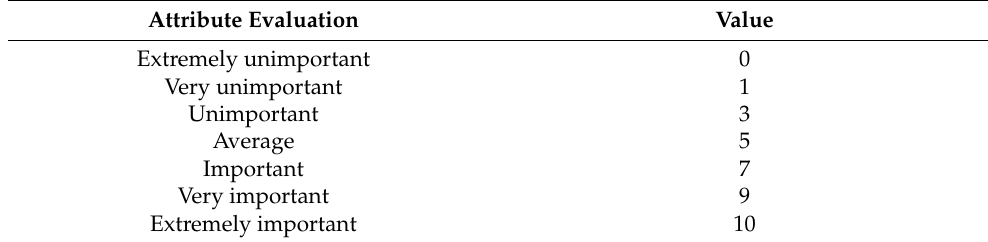
Table 5. Assignment of values for a 10-point scale [58].